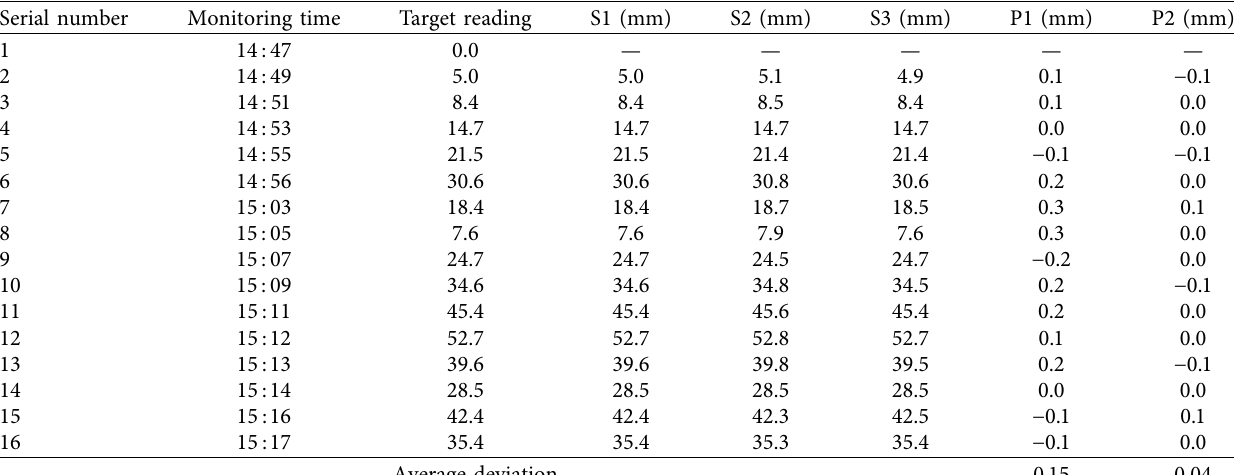
Table 2: Experimental table comparing the accuracy of the L1 target in the horizontal